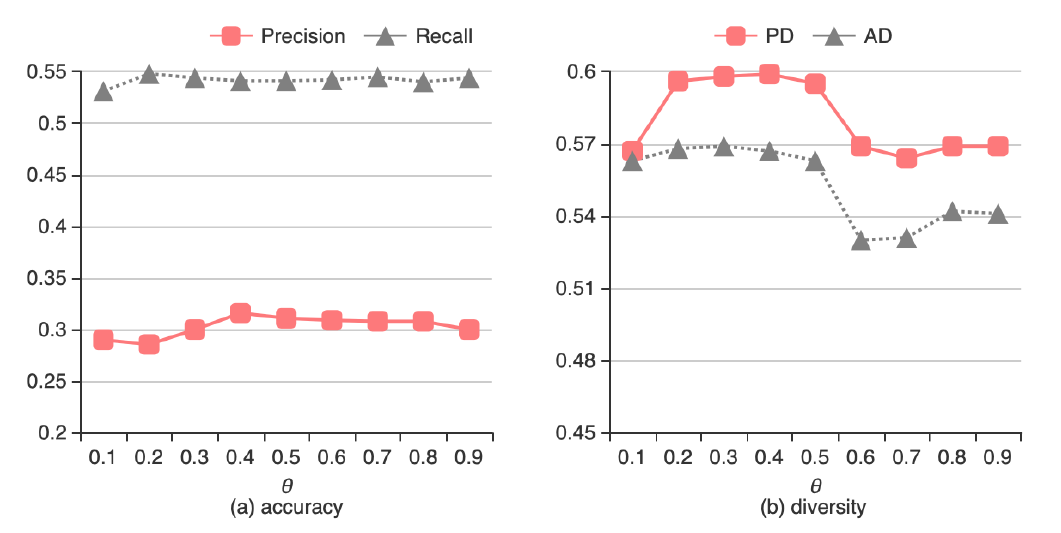
Figure 3. Effect of interest threshold γ on ( a ) accuracy and ( b ) diversity of DBTS. Figure 3 shows the accuracy and diversity of DBTS for different values of interest threshold γ . From Figure 3a we can see that γ has very little influences on either precision or recall. Figure 3b